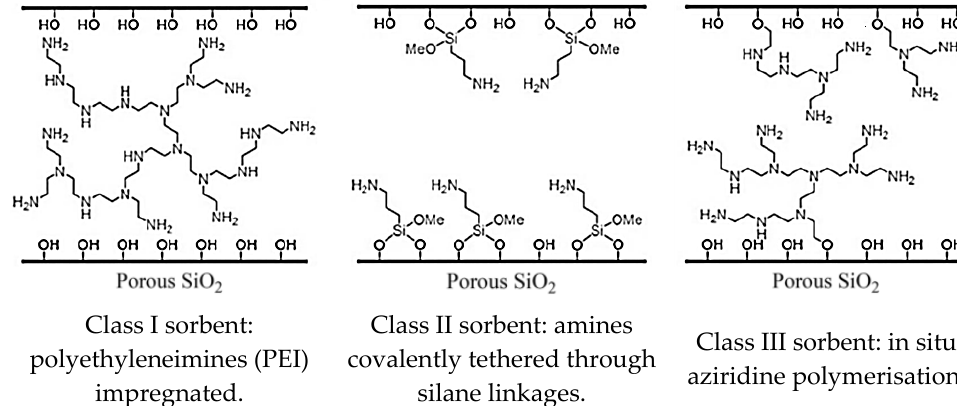
Figure 4. Three classes of amine-modified sorbents.